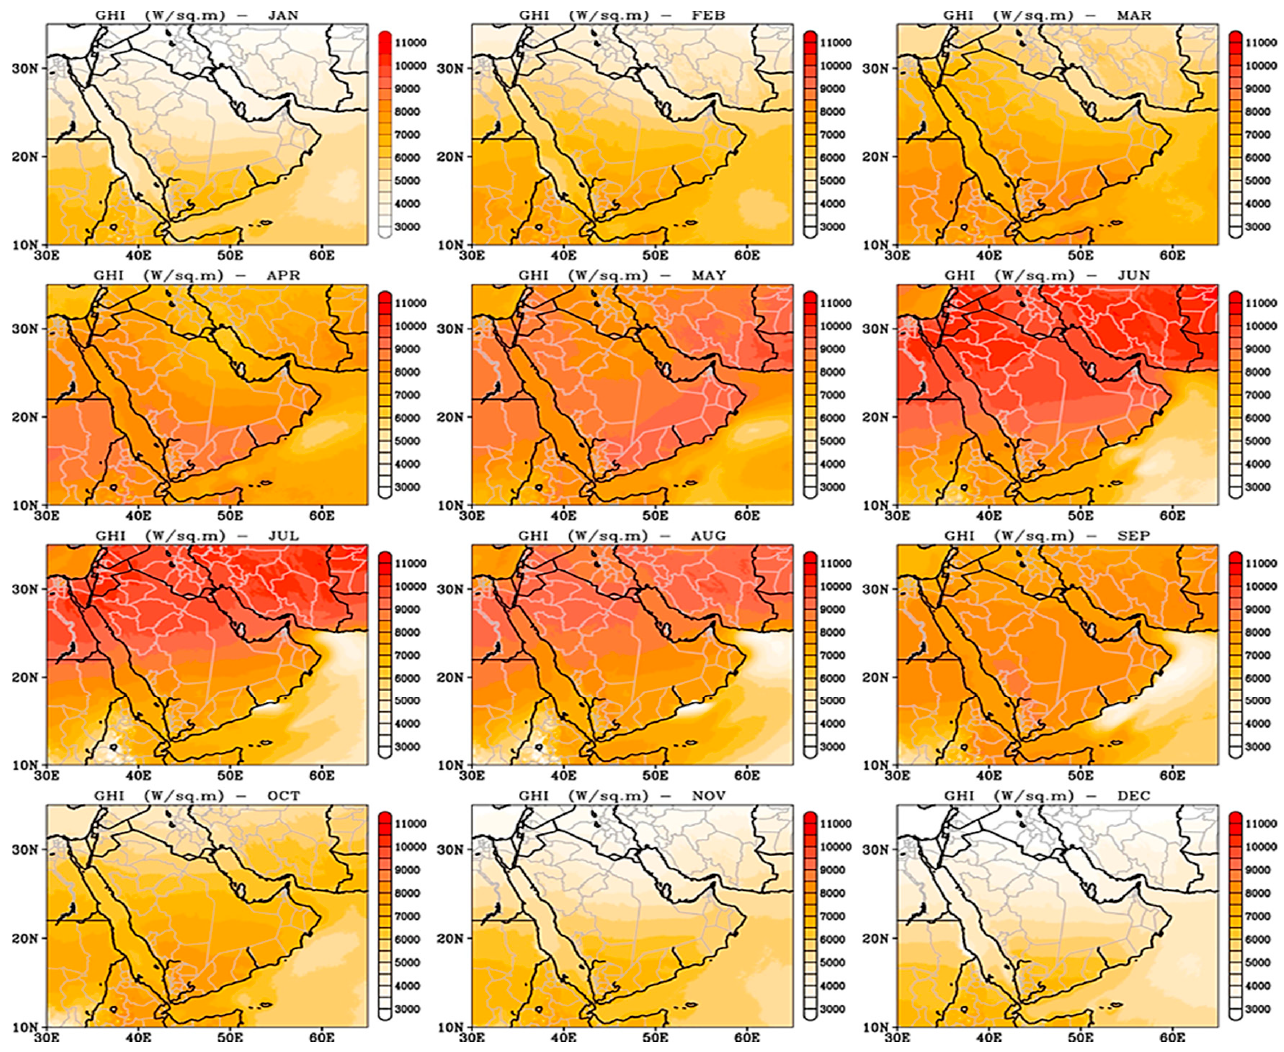
Figure 3. The monthly performance of GHI (W/m 2 ) over 37 years (1980–2017) in the GCC region. Copyright © 2021 Elsevier [55].